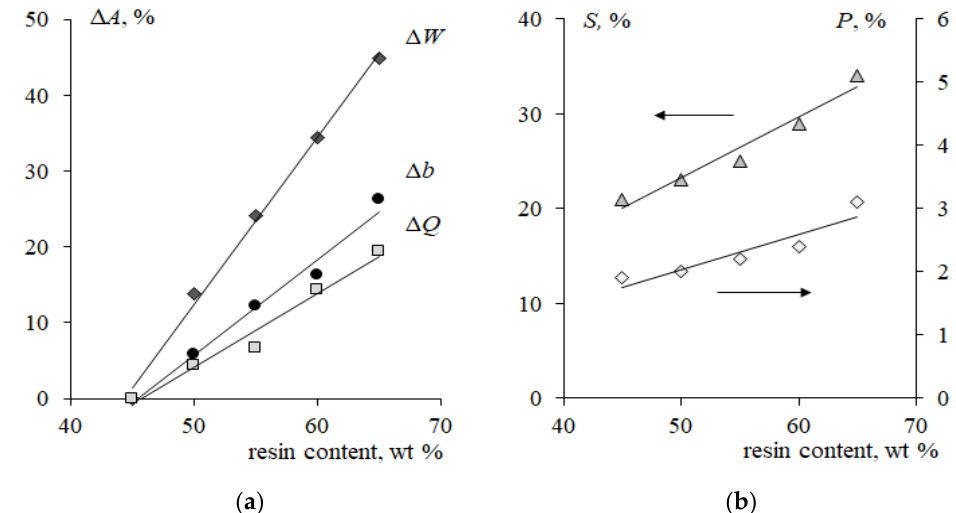
Figure 2. Relative changes in physical-chemical characteristics of cation-exchange membranes with different fractions of ion-exchanger ( a ) and their structural characteristics on the membrane surface ( b ). Relative changes Δ A % in physical-chemical parameters А were calculated according to the equation: ∆ A % = 100 ( A − A 45% )/ A 45% , where A 45% —value of a physical-chemical characteristic of the membrane with the ion-exchanger fraction of 45 wt %. Q — total exchange capacity per gram of the swollen membrane, mmol/g; W — water content, g H /g swoll.membr , %; b —swollen membrane thickness, μm; S — the fraction of the ion-exchange component, %; P — the fraction of macropores and structure defects, %.